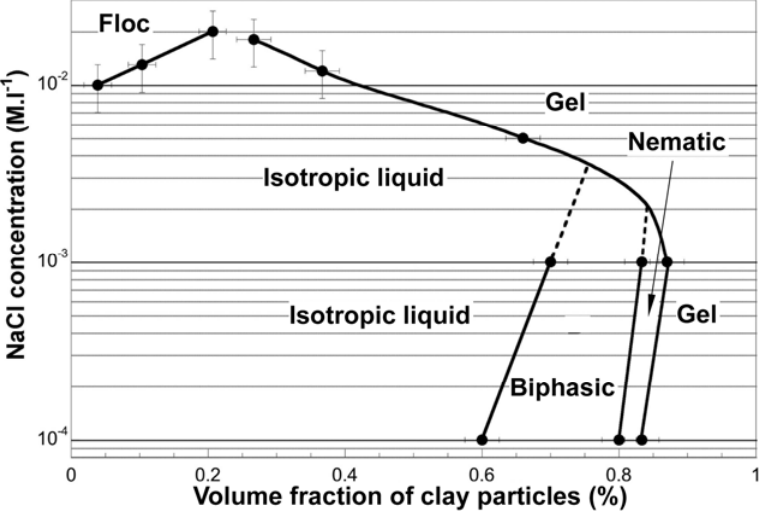
Figure 4. Phase diagram of an aqueous colloid of nontronite clay [96]. Copyright (2006) National Academy of Sciences,